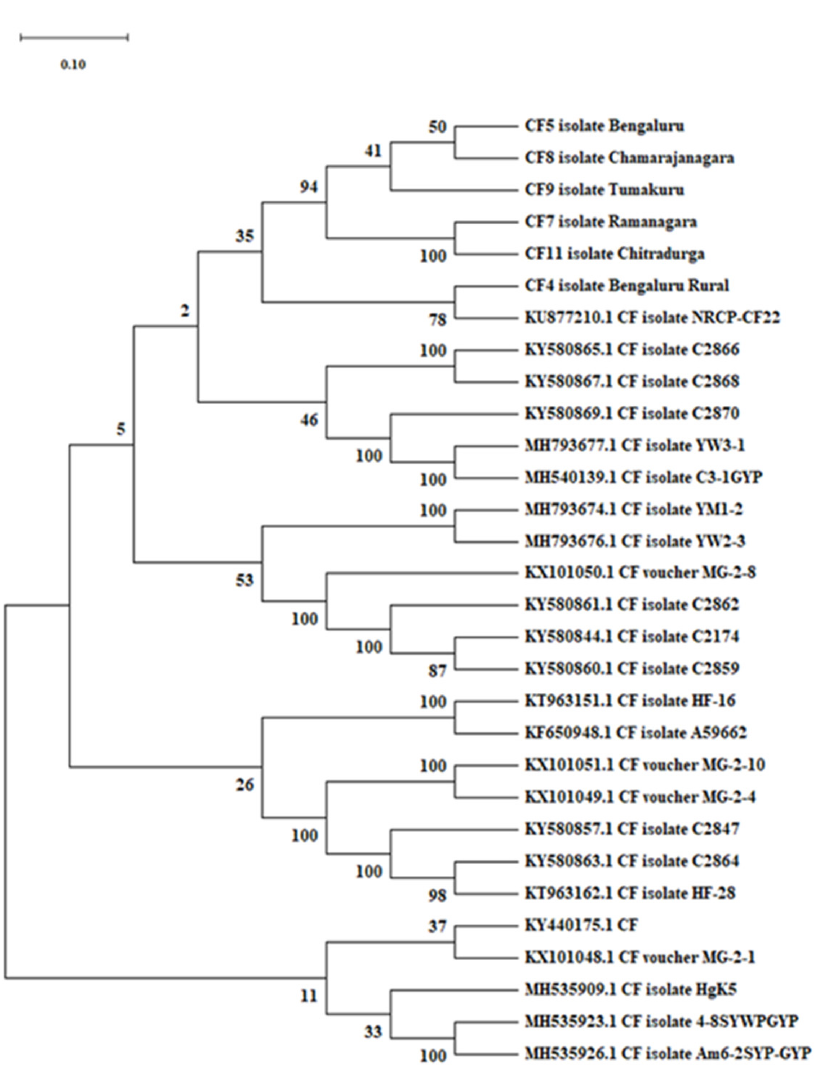
Figure 1. Phylogenetic tree showing evolutionary relationships between isolates of Ceratocystis fimbriata and selected GenBank accessions.